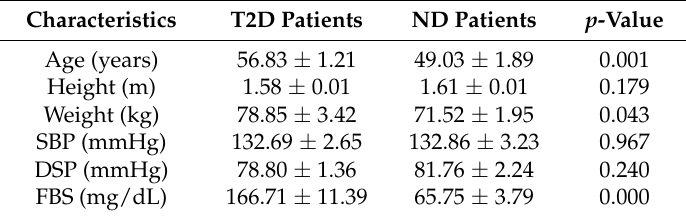
Table 1. Baseline and clinical characteristics of